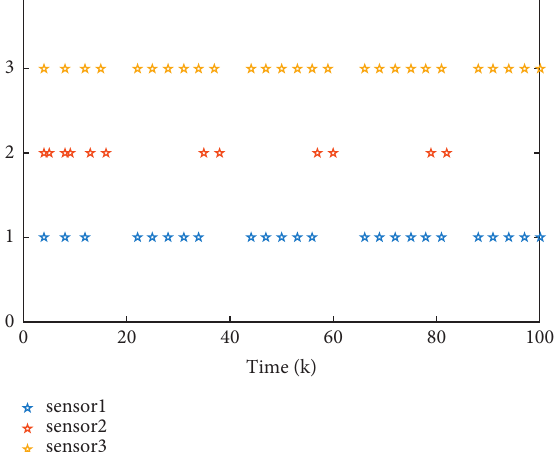
Figure 5: Dynamic triggering instants.